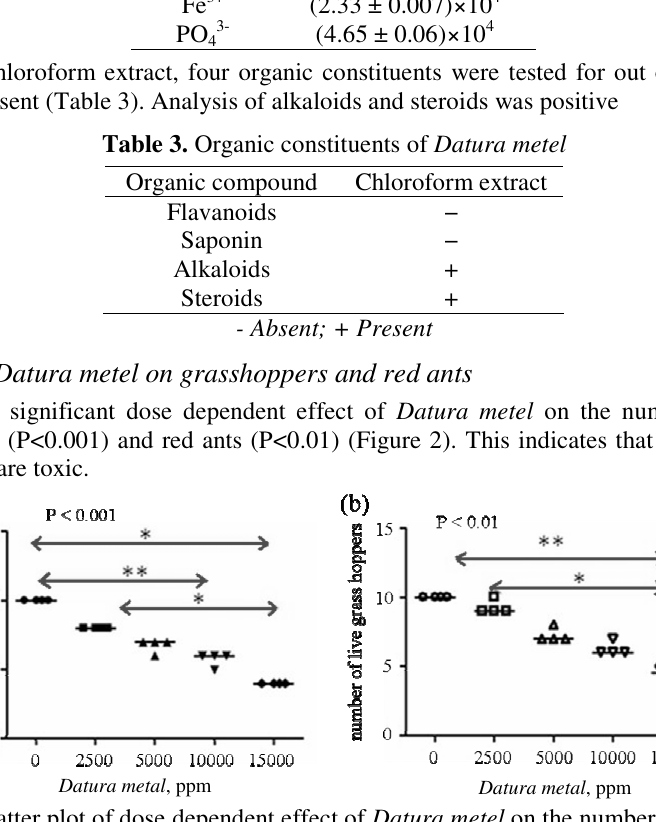
Figure 2. Scatter plot of dose dependent effect of Datura metel on the number of live (a) red ants; (b) grass hoppers in the experimental chamber. ANOVA; * =P<0.05, **